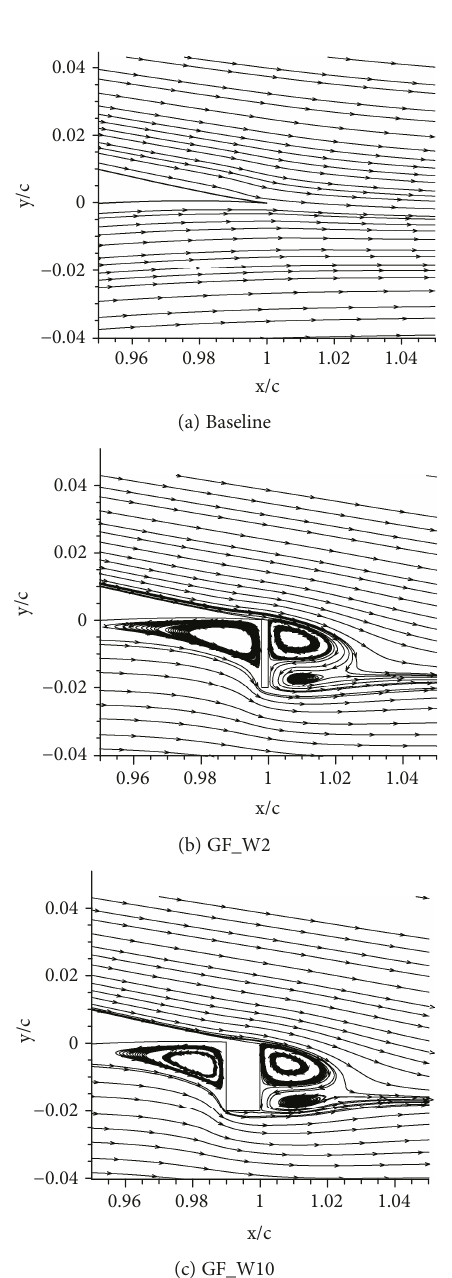
Figure 6: Comparison of the streamline at the airfoil trailing edge under di ff erent Gurney fl ap widths ( AoA = 1 03 ° ).